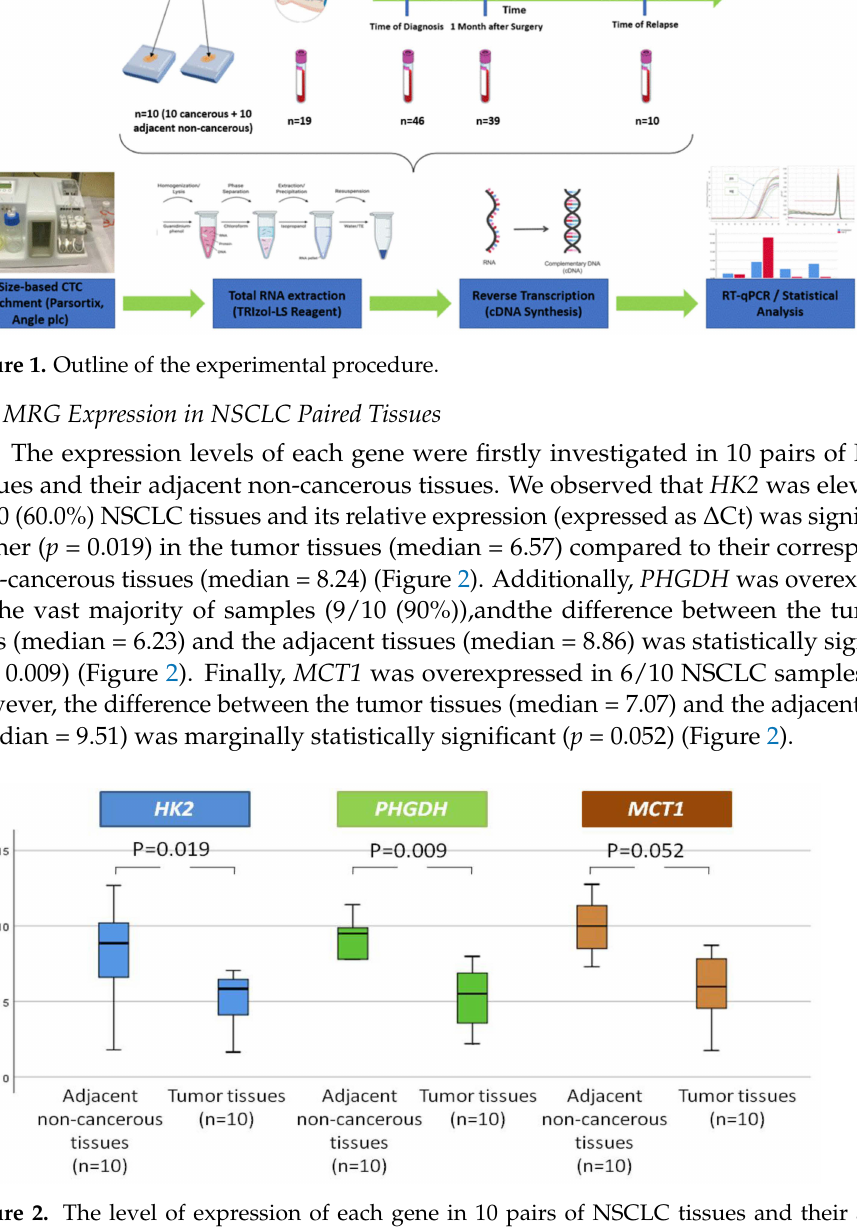
Figure 2. The level of expression of each gene in 10 pairs of NSCLC tissues and their adjacent non-cancerous